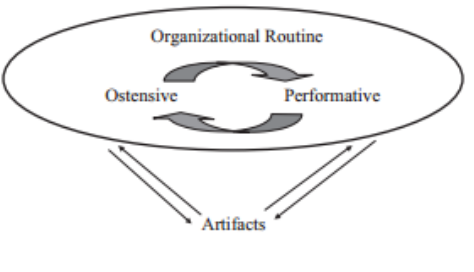
Figure 1 . Routine dynamics (Pentland & Feldman, 2005, p.